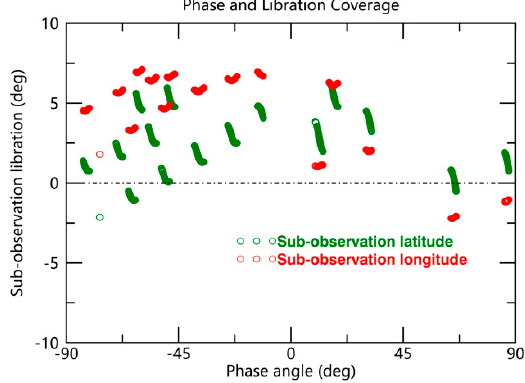
Figure 3. Lunar phase and libration coverage.